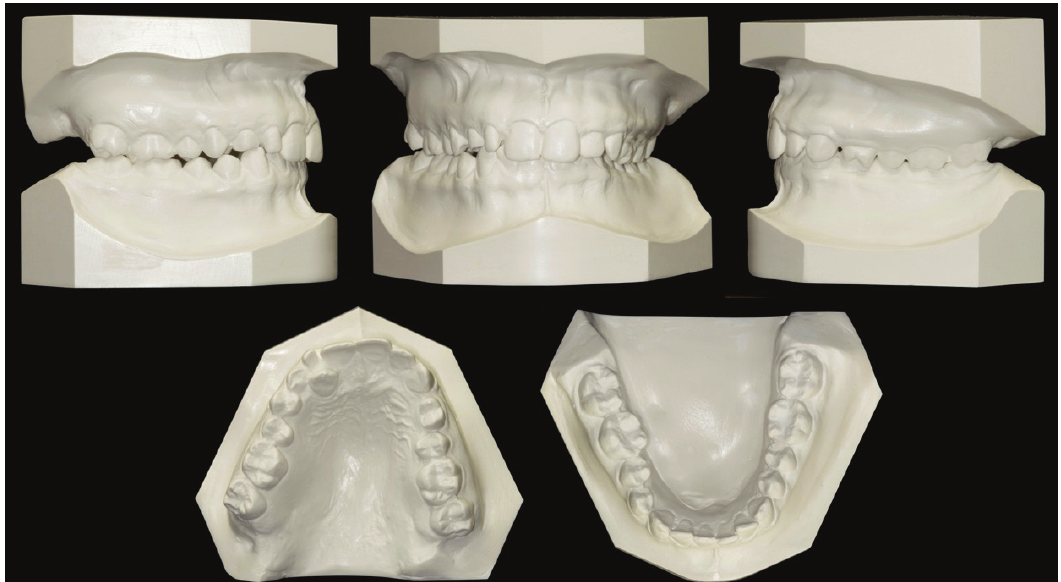
Figure 1b. Pretreatment study